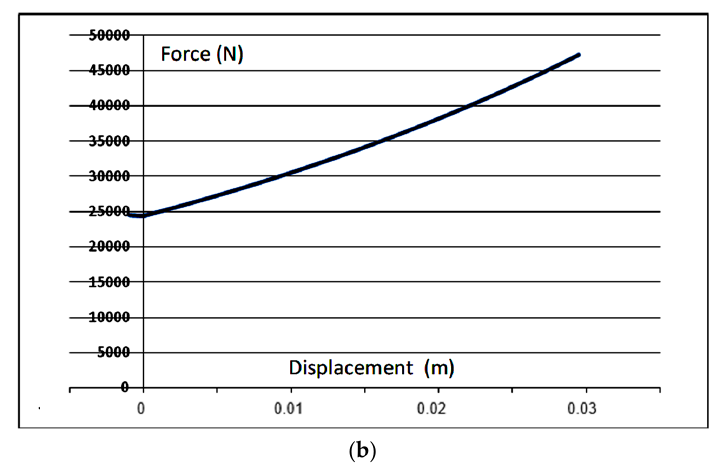
Figure 11. Internal reaction versus axial displacement of the pneumatic spring analyzed. ( a ) Displacement versus time after application of an impulsive step load F 0 =10 KN ; ( b ) Force/displacement relation of the pneumatic spring.